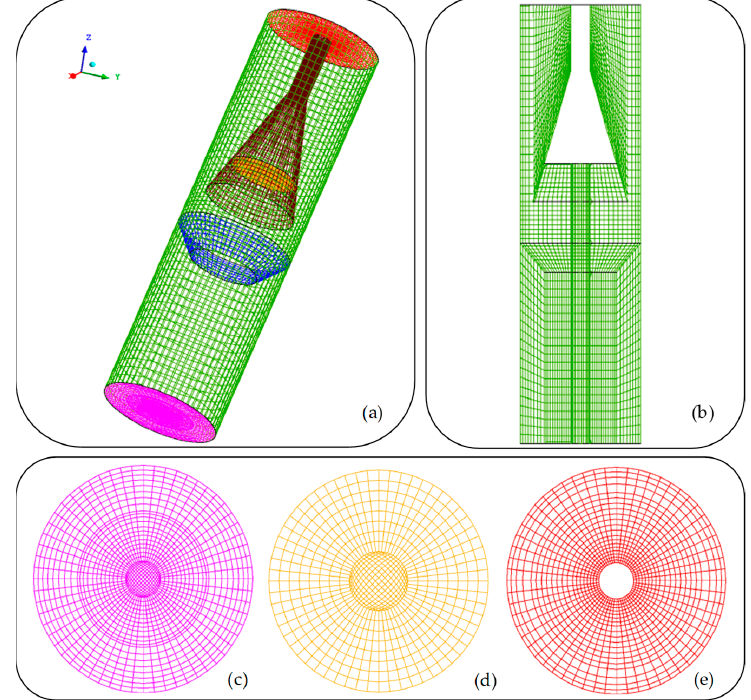
Figure 3. Mesh representation with deflector inclination downwards: ( a ) overview, ( b ) plan yz, ( c ) inlet (z = 0 m), ( d ) biogas outlet (z = 2.29 m), and ( e ) output of sludge and biogas (z = 3.58 m).